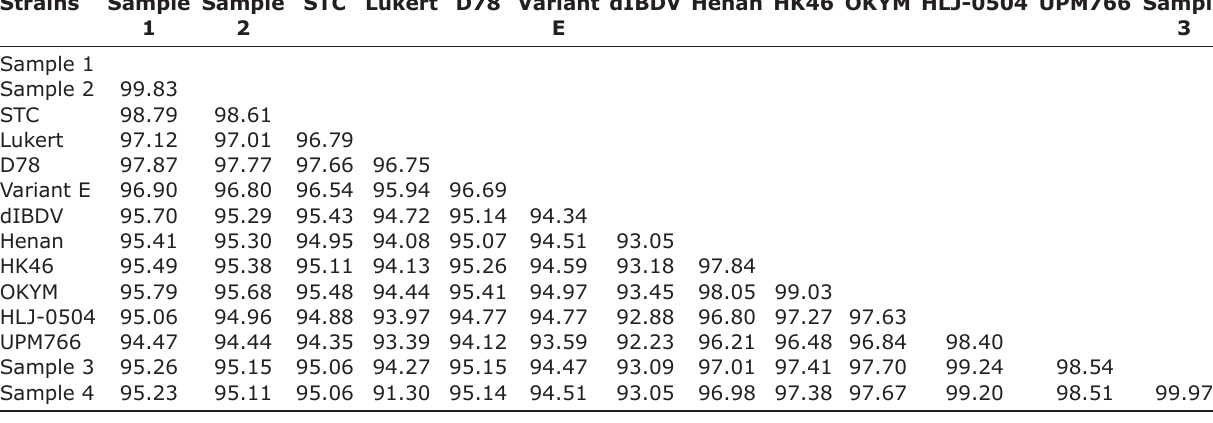
Table-3: Comparing percent similarity of segment A (nucleotide 250-3169) between samples 1 and 4 and reference sequences from the GenBank.